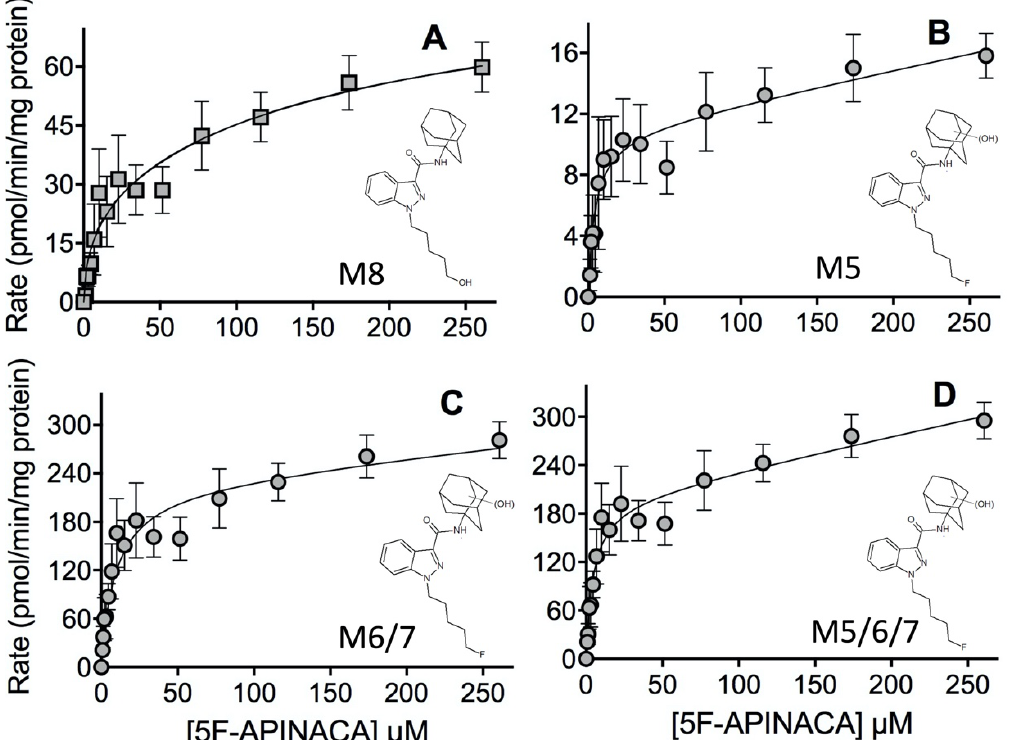
Figure 4. Steady-state kinetic profiles for 5F-APINACA primary metabolites from microsomal reactions. ( A ) Panel shows the kinetic data for oxidative defluorination of 5F-APINACA into M8 (squares, light gray), while panels in ( B , C ) reflect results for the early and late eluting monohydroxy adamantyl metabolite isomers M5 and M6 / M7 (circles, light gray). ( D ) Both data sets were combined to generate the kinetic profile and analyzed as a reflection of total monohydroxylation of adamantyl group of 5F-APINACA (circles, light gray). Steady-state reaction conditions and data analyses were carried out as described in Materials and Methods. Each data point is the average of seven replicates from three separate experiments and the displayed curve reflects the best-fit model for the data. The corresponding mechanism and constants are reported in Table 2. Table 2. Steady-state kinetics for 5F-APINACA metabolism by human liver microsomes a .